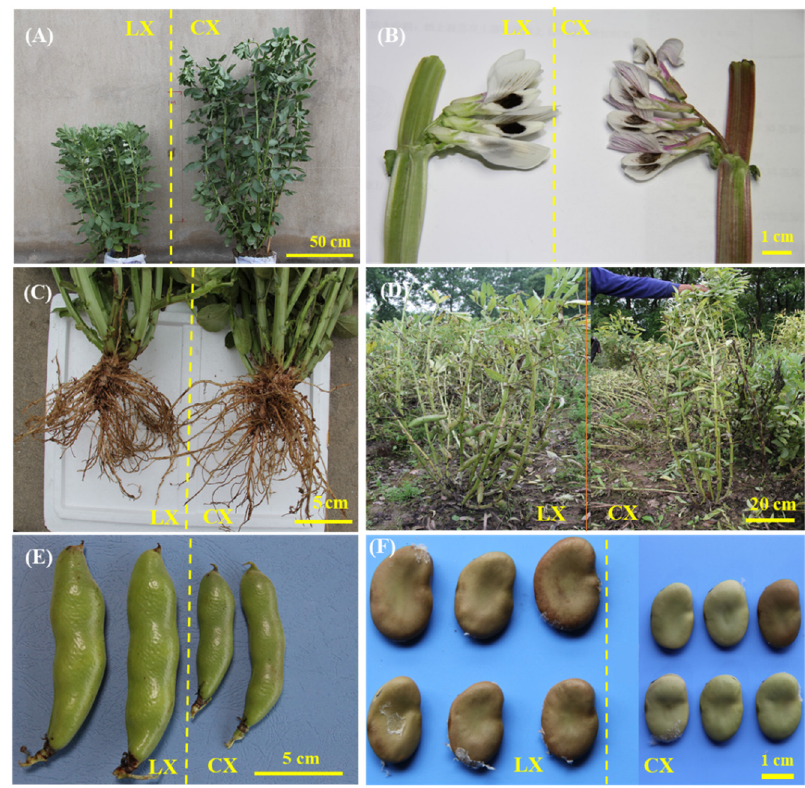
Figure 1. Differences in plant morphology, flowers, stem, roots, pods, and seeds between Lingxiyicun (LX, left panel of each subfigure) and Cixidabaican (CX, right panel of each subfigure). ( A ) Plant morphology at flowering stage, ( B ) flowers and stems, ( C ) roots at flowering stage, and ( D ) whole plant morphology at mature stage. ( E ) Fresh pods and ( F ) dried seeds.